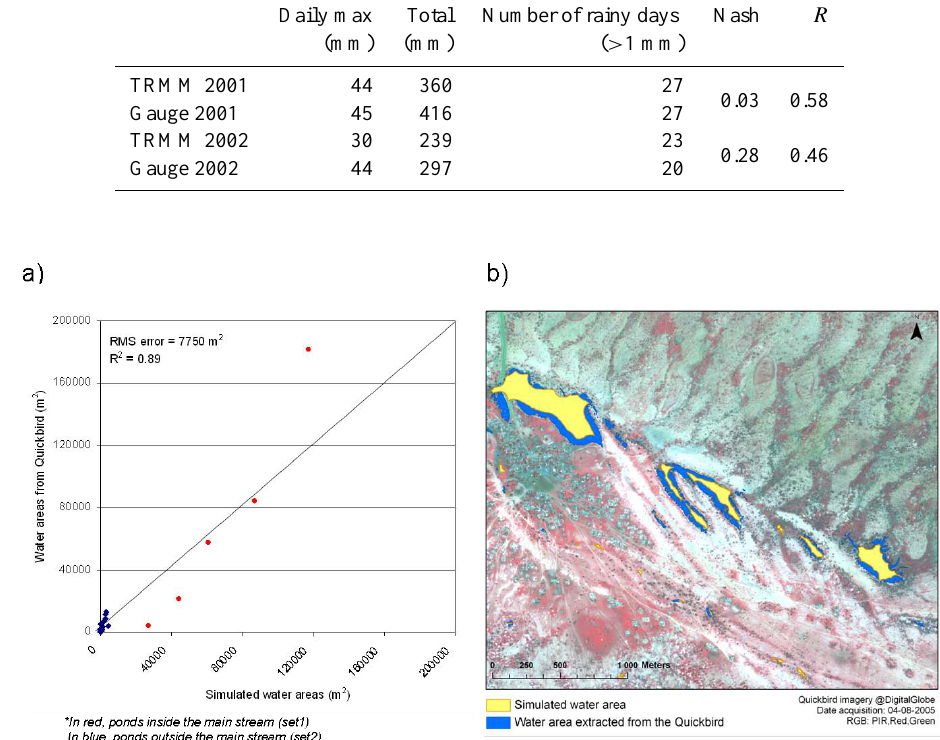
Fig. 7. Comparison of observed (Quickbird imagery, 20 August 2007) and modelled water areas; (a) Graphical representation of the observed water area derived from Quickbird imagery versus modelled water areas, and (b) Map of the observed (in blue) and modelled (in yellow) water areas, Barkedji, Senegal. To represent simulated pond surface areas on the map, a buffer was applied to the observed pond polygons to trim them to the simulated surface area. The thickness of the buffer to be applied for each pond was determined by calculating the pond √ radius as ( A / π) , with A the simulated surface of the